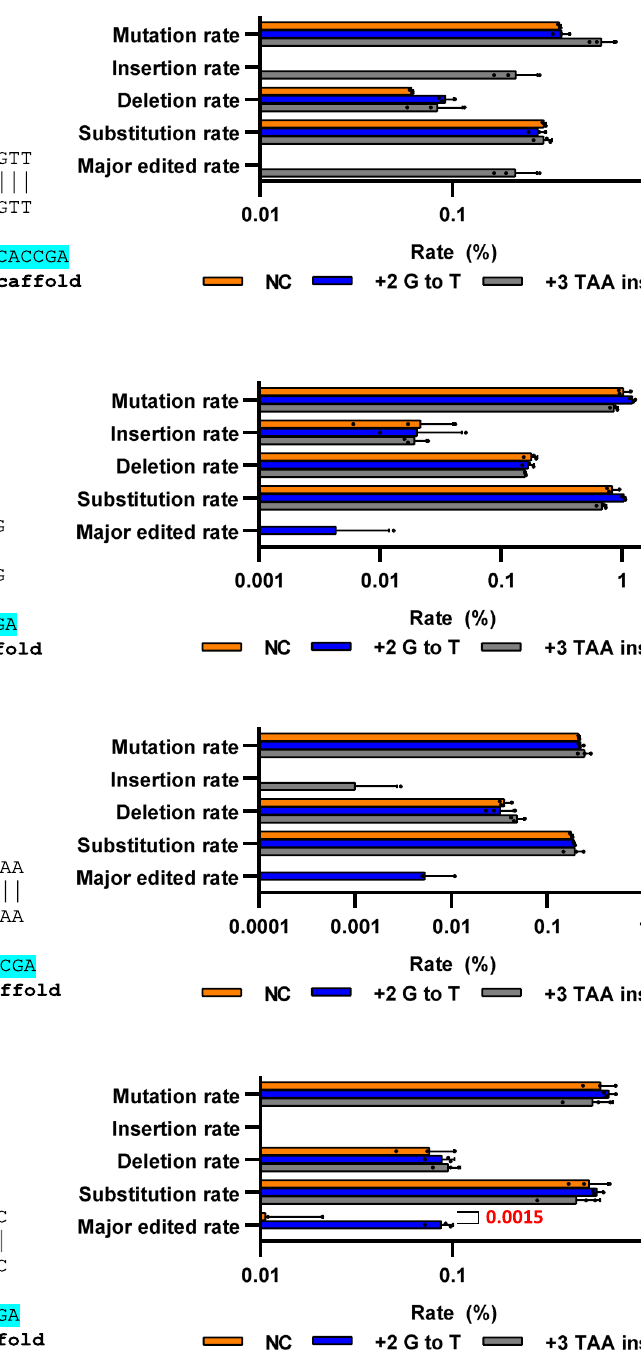
Fig. 6| Off-target primeediting patterns.a Editingpatternsinducedbythe HEK4 (+3TAAins)pegRNAatthe HEK4 -off3sitepredictedbyTAPE-seq. b Editingpatterns induced by the HEK4 (+2G to T) pegRNA at the HEK -off7, HEK -off10, and HEK - off22 sites predicted by TAPE-seq; two-sided unpaired student t test. NC negative